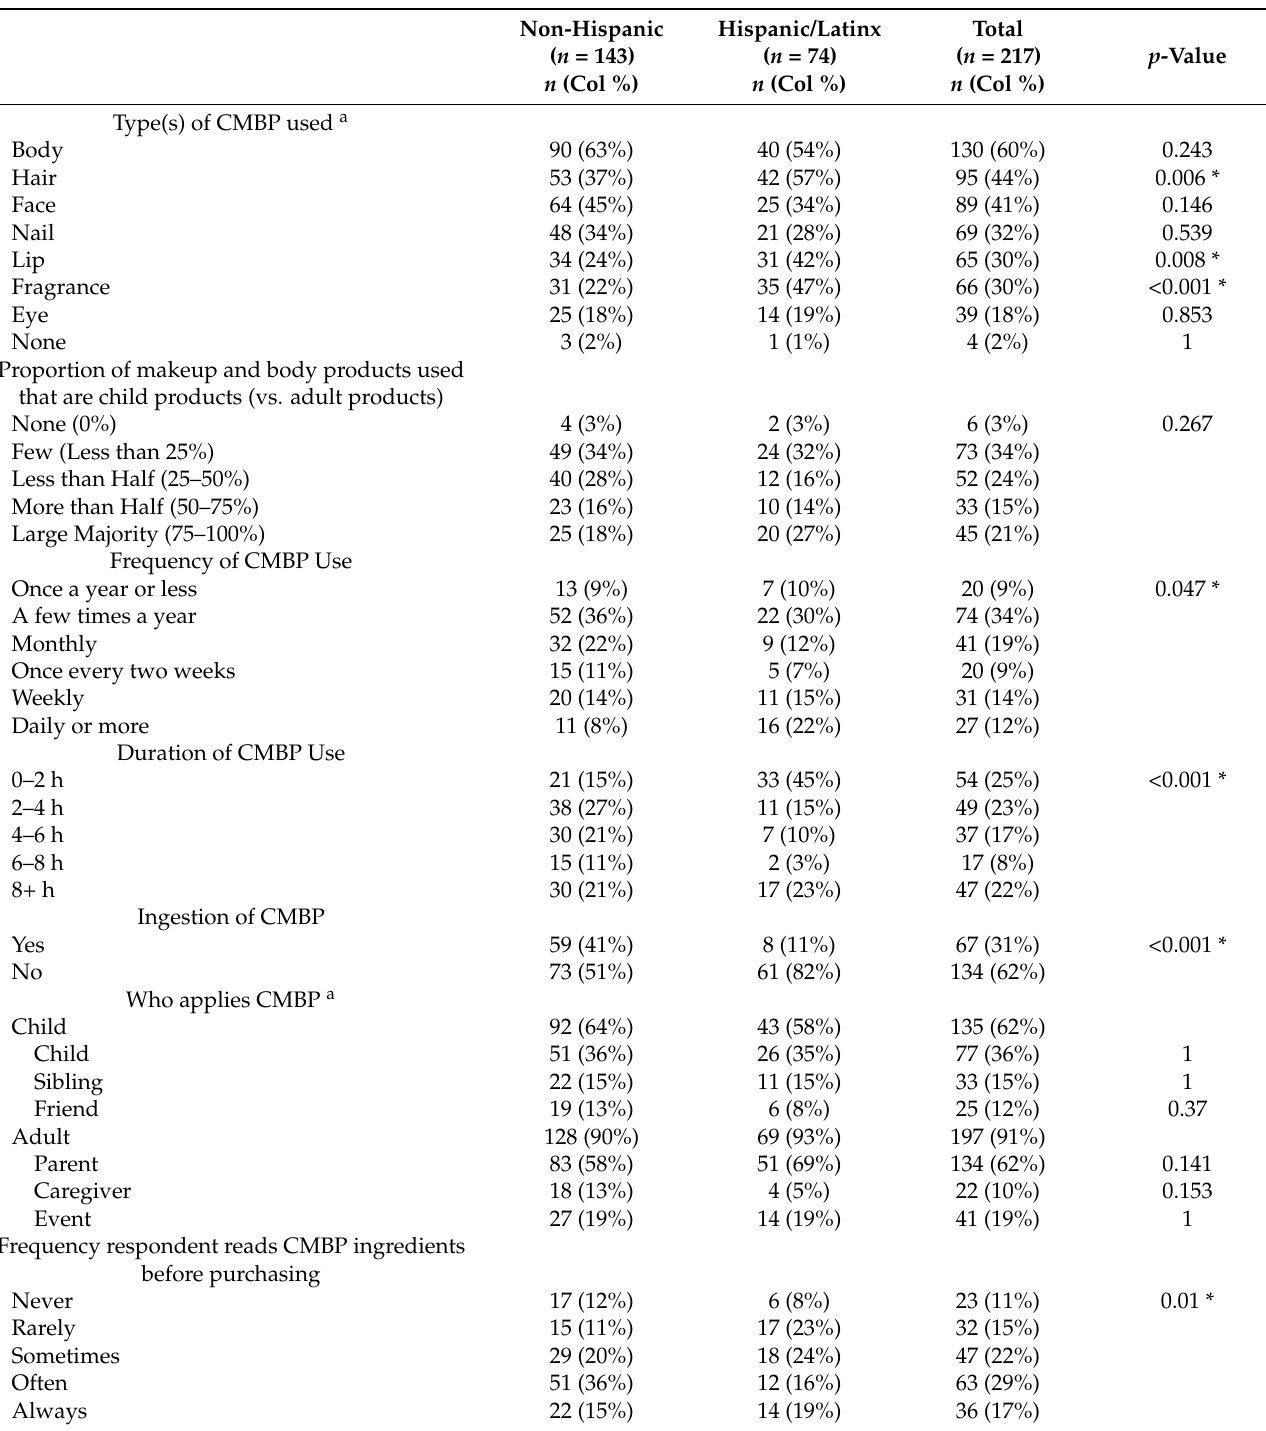
Table 3. CMBP use by parent